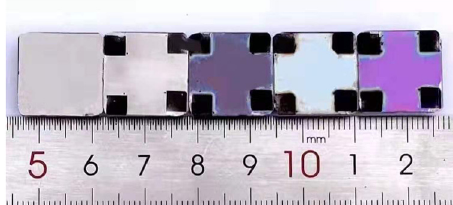
Figure 1: Macro - morphology of the coated textured